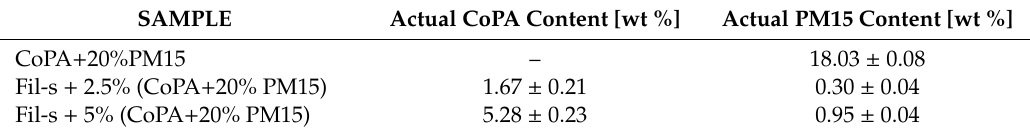
Table 1. Actual copolyamide (CoPA) and nanofiller (PM15) contents in the blends with